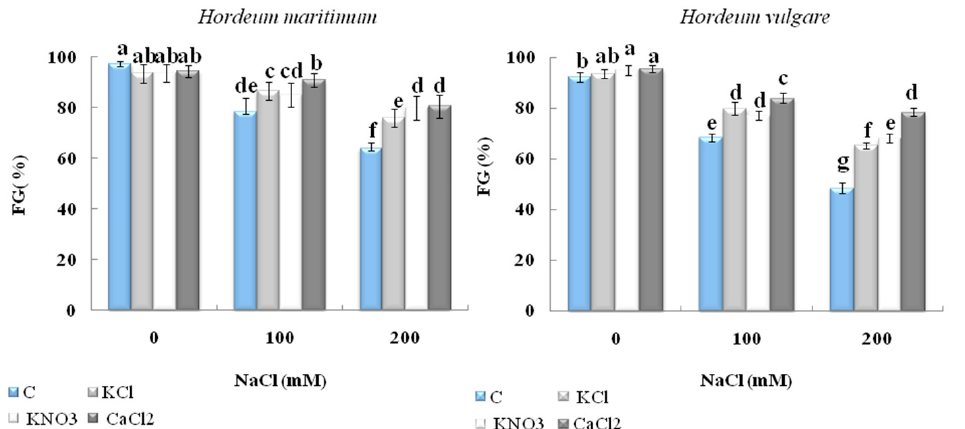
Figure 1. Effect of KCl, KNO 3 , and CaCl 2 seed priming on the final germination rate (FG%) of two barley species, Hordeum maritimum and Hordeum vulgare (L. Manel),subjected to various salt concentrations (0, 100, and 200 mM NaCl) for 7 days at the germination stage. Values are means of 20 replicates ± standard error. Data with the same letter are not significantly different at p < 0.05 (Duncan’s test).